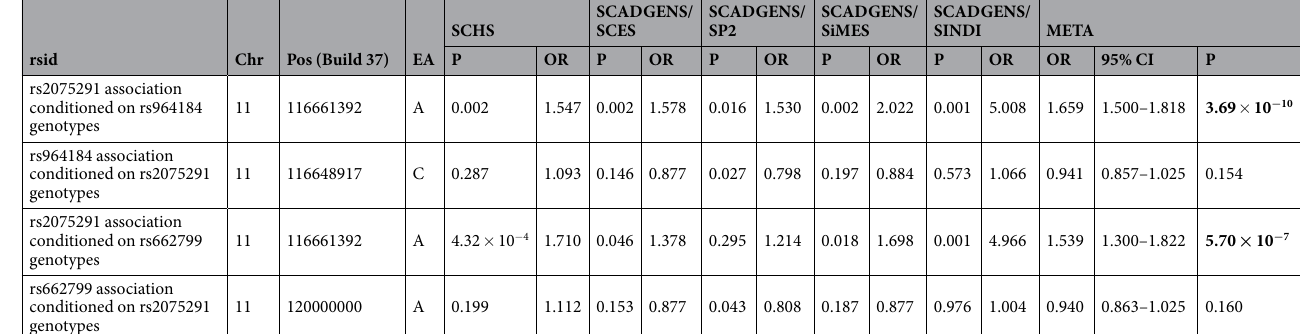
Table 2. Conditional probability analysis for APOA5 variants (rs2075291 and rs964184) with CAD in individual datasets used in the study and after meta-analysis. EA: Effect allele; OR: odds ratio; CI: confidence